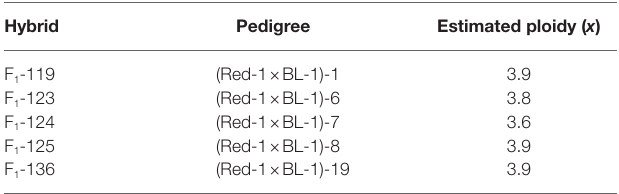
TABLE 1 | Flow cytometric estimates of ploidies of 4 x F 1 (Red-1 × BL-1) hybrids [ Trifolium repens × (4 x Trifolium ambiguum × 4 x Trifolium occidentale )], with the expected genomic composition P r O r AO.